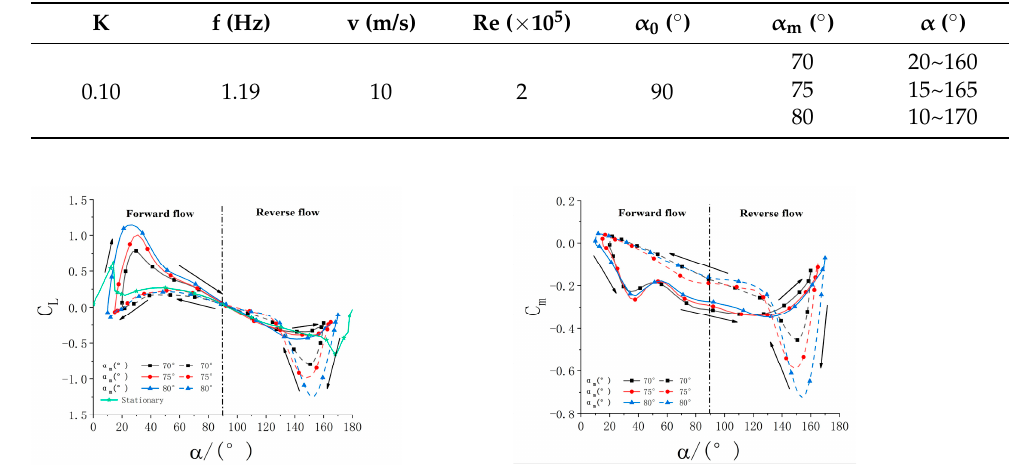
Table 12. Experimental conditions of forward and backward flow switching of the airfoil.